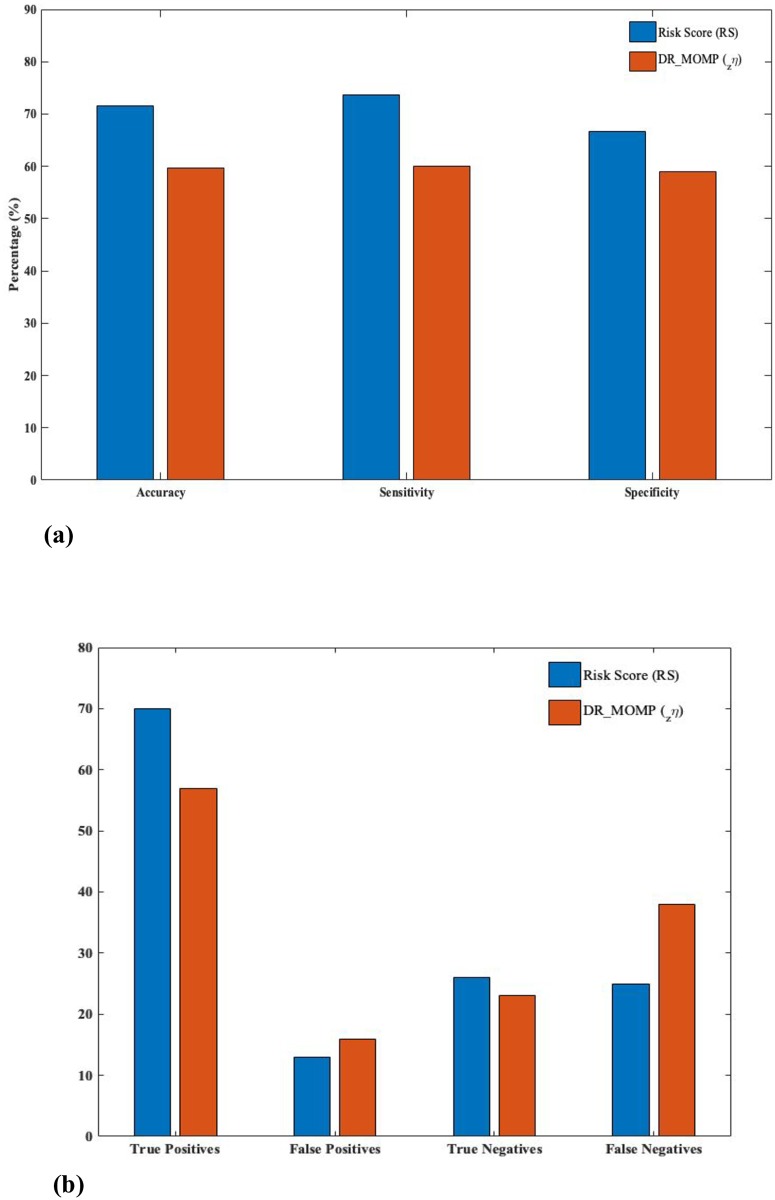
Prediction of favorable/unfavorable outcomes.(a) RS, at mean cutoff, is shown to predict favorable and unfavorable outcomes with an increased sensitivity (73.68%), specificity (66.66%) and accuracy (71.64%) as compared to DR_MOMP’s zη (sens = 60%, spec = 58.9%, acc = 59.7%). (b) A corresponding improvement in predicted positive (favorable) and negative (unfavorable) outcomes and reduced false predictions, by implementing RS, is presented here. (Favorable: RS≥0, Unfavorable: RS<0).